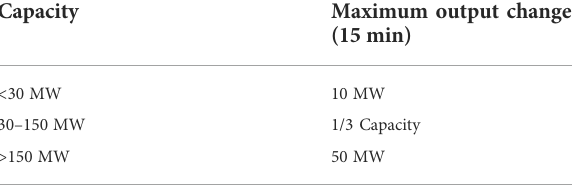
TABLE 1 Guidelines for wind farm grid